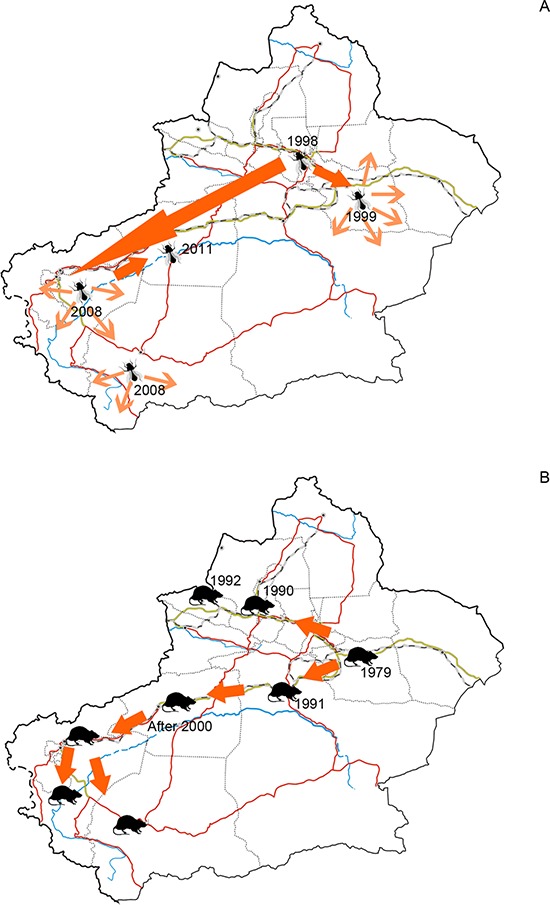
(A) Dispersal of silverleaf whitefly (Bemisia tabaci) in Xinjiang and (B) Dispersal of brown rat (Rattus norvegicus) in Xinjiang.Figure 5A was plotted according to Guo et al. (2012a) and 5B was plotted according to Zhang, Tao & Mahmut (1997).